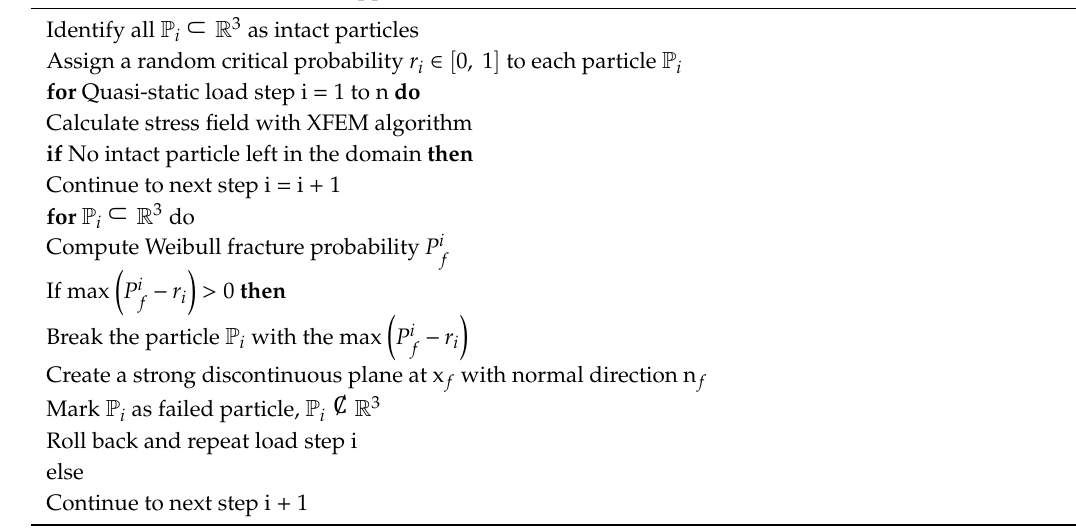
Algorithm 1 Particle fracture approximation Algorithm 1. Particle fracture approximation